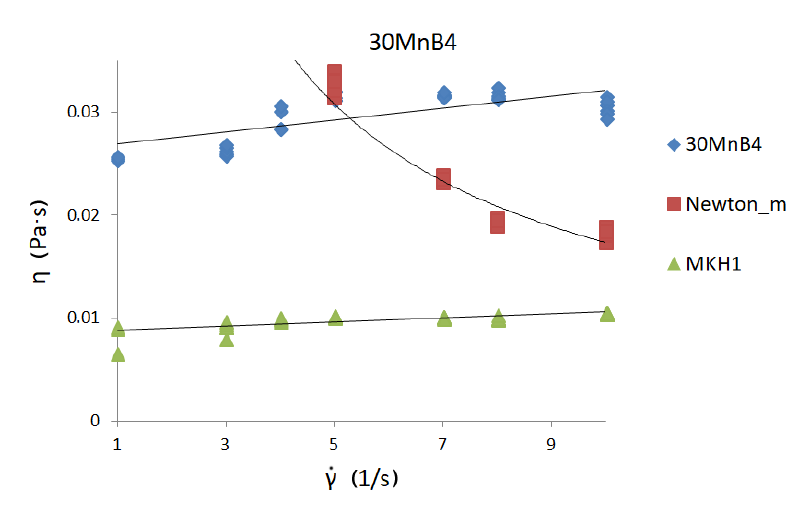
Figure 9. Viscosity curve for 30MnB4 steel at 1530 °C.